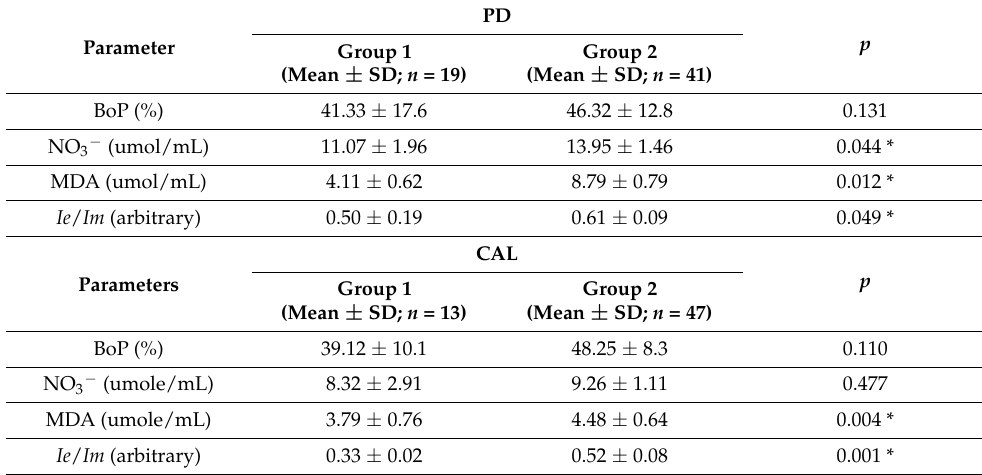
Table 3. Depth classification of PD and CAL in patients with periodontitis.